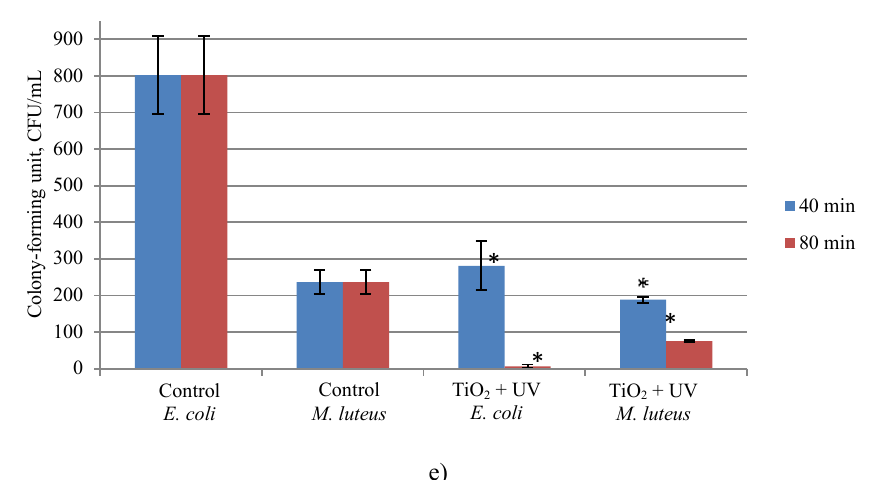
Fig. 7 Viability of E. coli and M. luteus (yellow) cells in mixture evaluated by SP method (n=3): a) negative control with none-treated cells; b) effect of TiO 2 ; c) effect of UV; d) effect of TiO 2 + UV. The experiments were performed at 22 °C, the initial amount of bacteria was 2.7×10 6 cfu/mL, dilution factor 1000. 1 mg/mL of TiO 2 was used and the intensity of UV irradiation was 2 mW/cm 2 . *statistically significant difference compared to control group, using one-way ANOVA, p < 0.05.